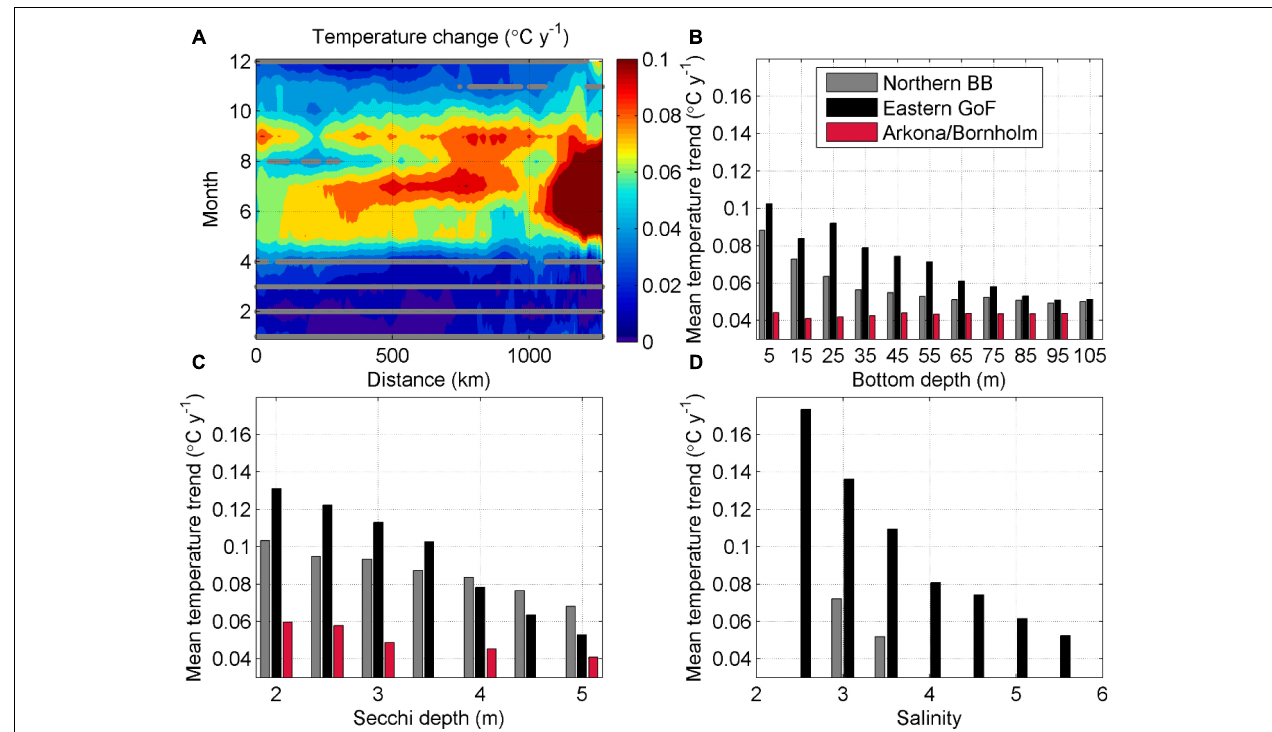
FIGURE 8 | (A) Seasonal course of SST trend ( ◦ C year - 1 ) along the line from Arkona basin to the Eastern Gulf of Finland ( Figure 3 ). Gray lines/dots at subplot (A) show locations/months, where/when the trend was not significant ( p > 0.05). Mean SST trend ( ◦ C year - 1 ) at different (B) sea bottom depths, (C) Secchi depth (m), and (D) upper layer salinities in the Eastern Gulf of Finland, Northern Bothnian Bay, and Arkona/Bornholm area. Mean Secchi depth data from March to October 2003–2012 (Stock, 2015) and mean surface salinity from April to October (Janssen et al., 1999) were used. Salinity in this figure is given on the Practical Salinity